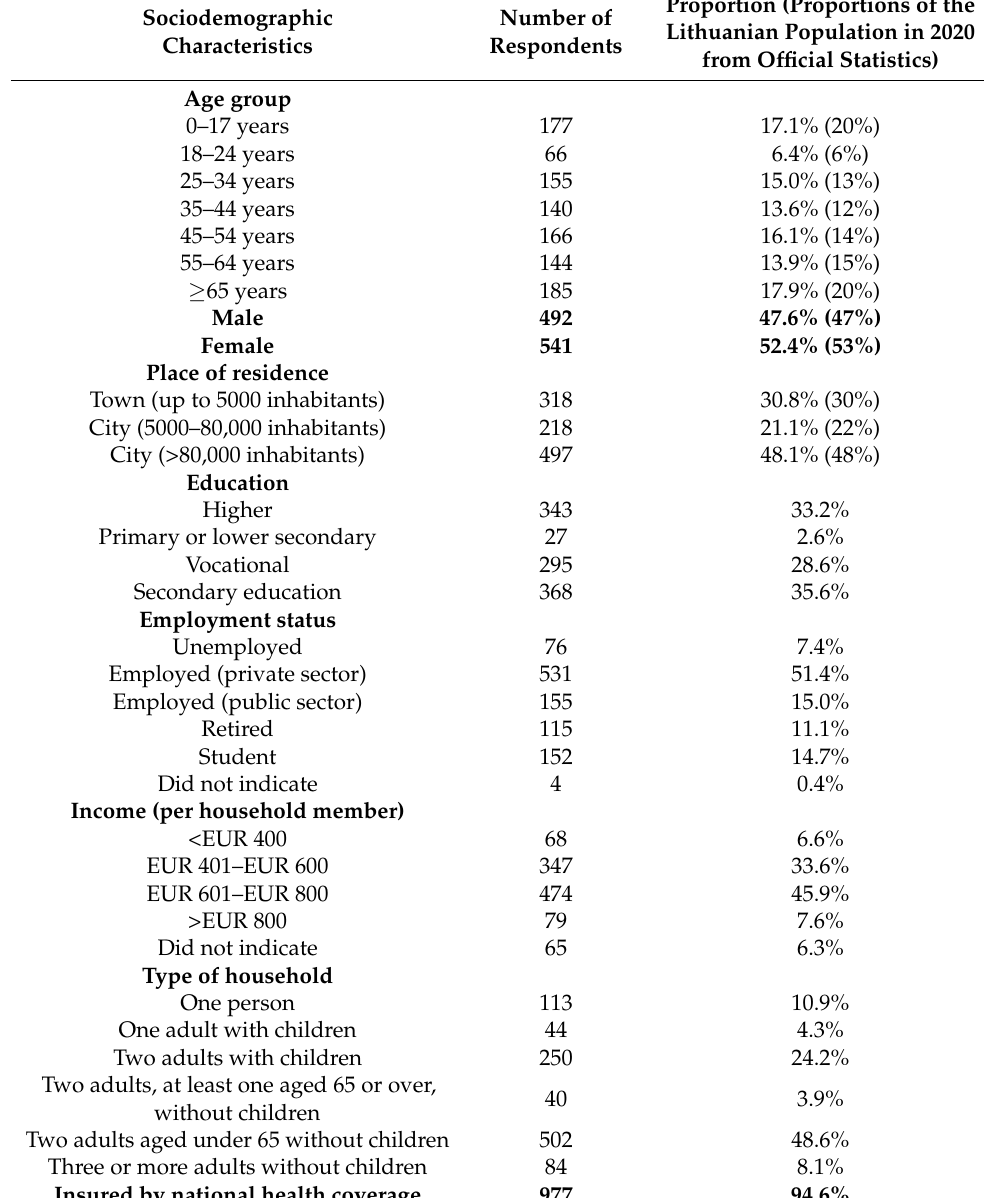
Table 1. Sociodemographic characteristics of